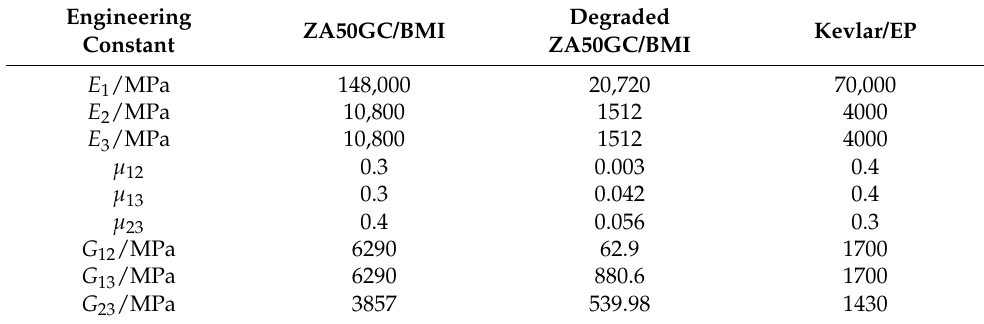
Figure 6. Illustration of the FEM model. Table 1. Engineering constants of unidirectional composite materials for FEM